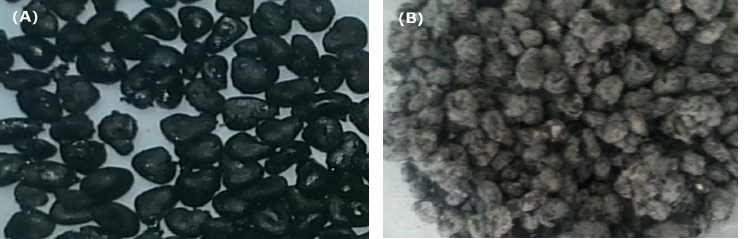
Figure 1. Relative activity (%) as a function of enzyme/support ratio during immobilization of the BCL on biochar by CB.